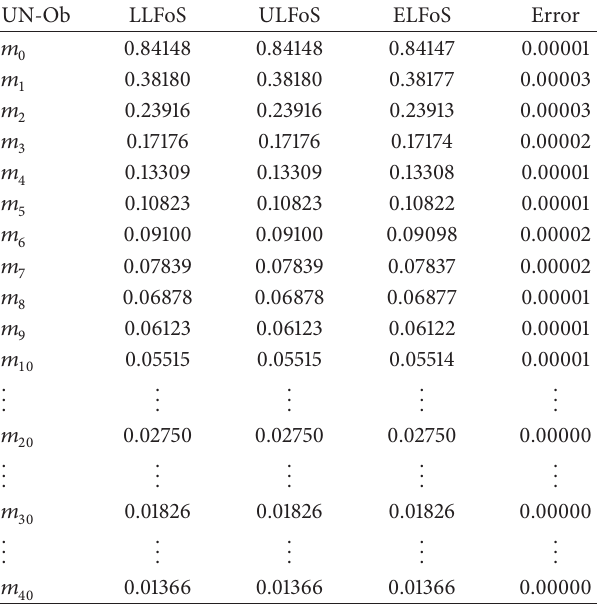
Table 4: Upper and lower bounds for Example 3 for 𝑁 = 50 .